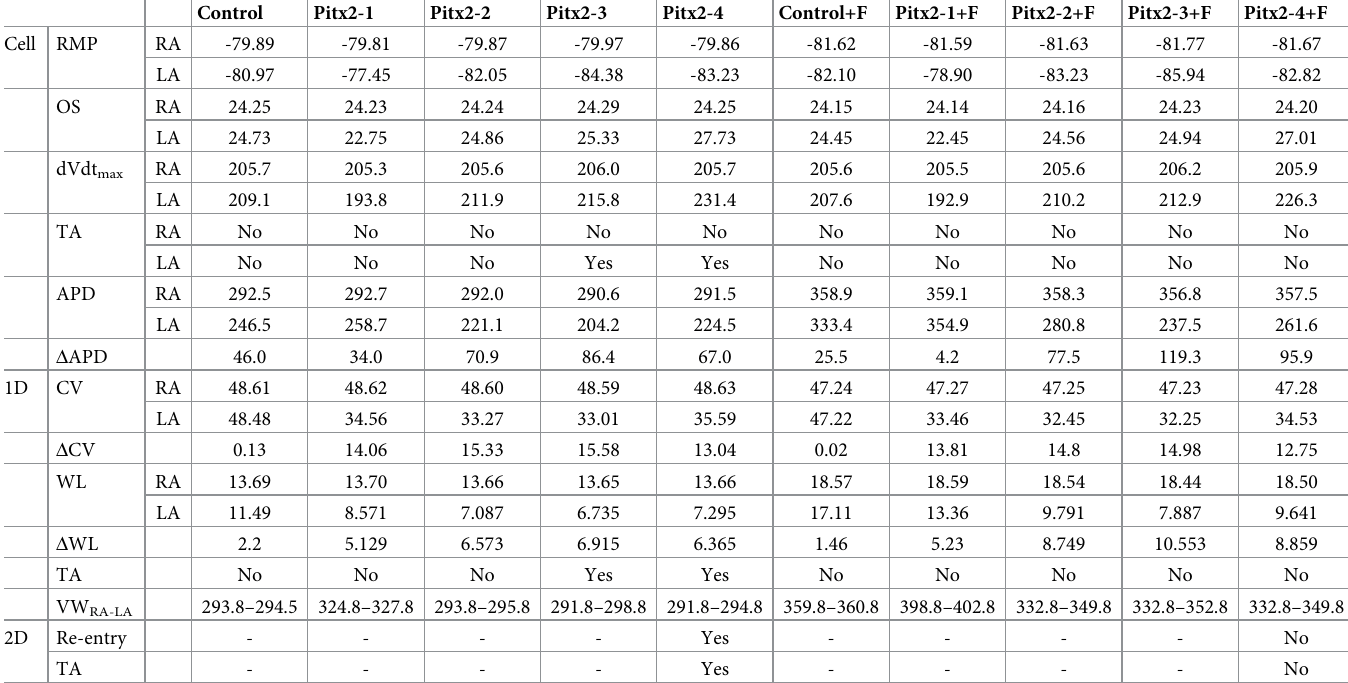
Table 2. A quantitative summary of electrophysiology characteristics.